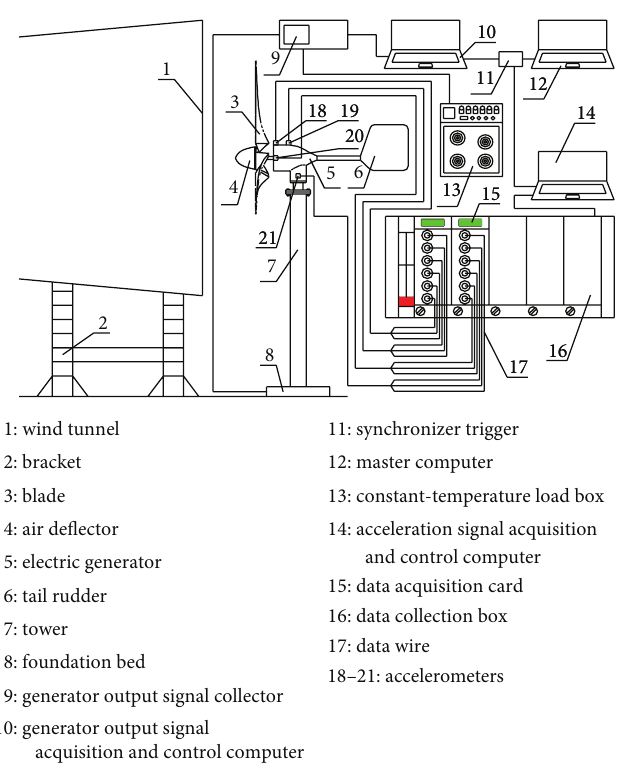
Figure 6: Dynamic frequency test system.